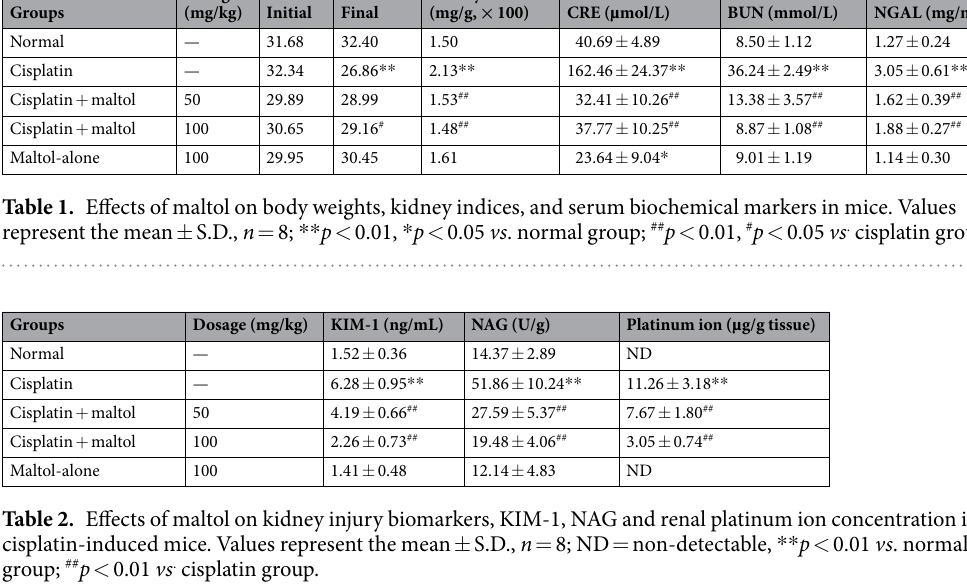
Table 2. Effects of maltol on kidney injury biomarkers, KIM-1, NAG and renal platinum ion concentration in cisplatin-induced mice. Values represent the mean ± S.D., n = 8; ND = non-detectable, ** p < 0.01 vs . normal group; ## p < 0.01 vs . cisplatin